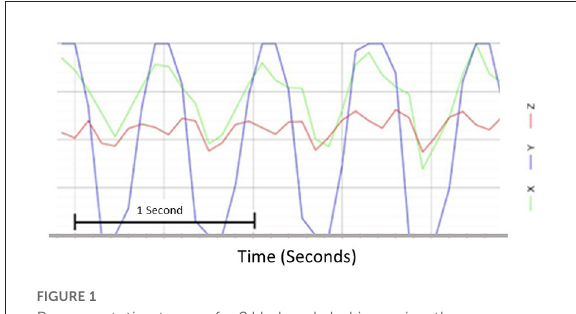
FIGURE1 Representative trace of a 2Hz head shaking using the accelerometer in a graph format. Headshake stimulus using an accelerometer was measured in the y-axis.